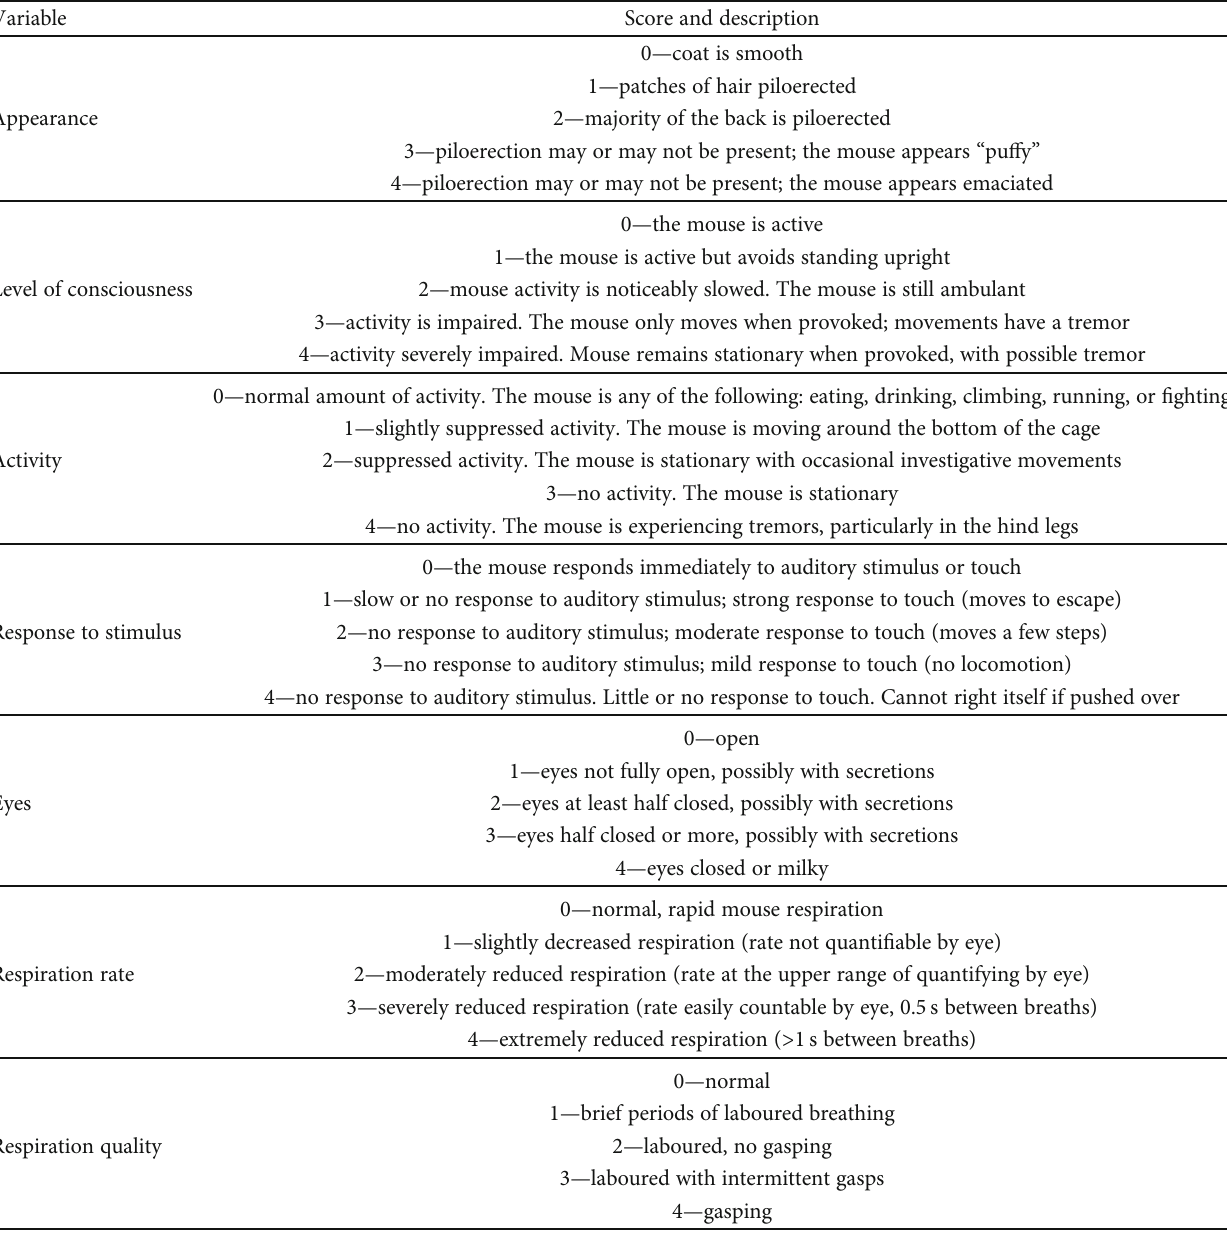
Table 1: Murine Sepsis